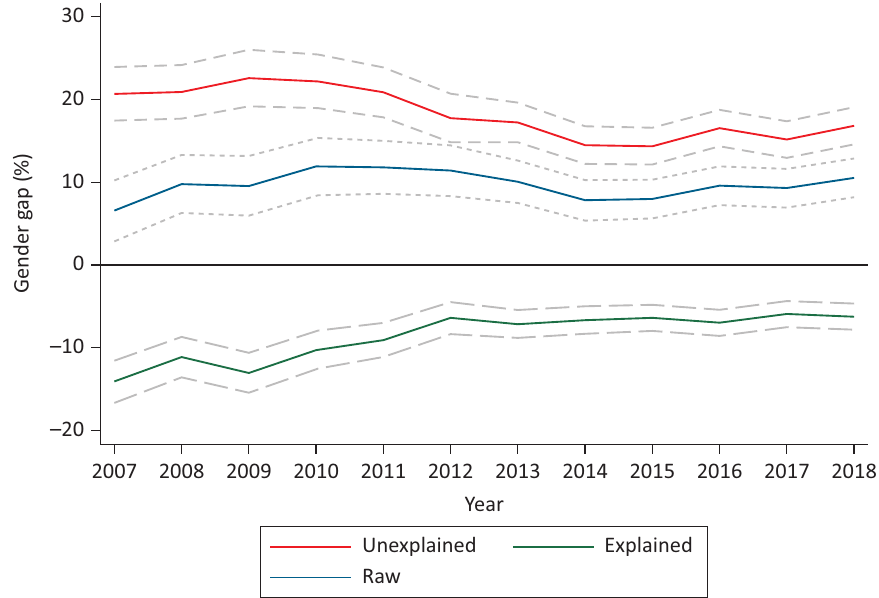
Figure 1. Wage gap decomposition. Notes: Raw gender wage gap is measured as ln(wage men)—ln(wage women); solid lines refer to point estimates; dashed lines denote 95% confidence